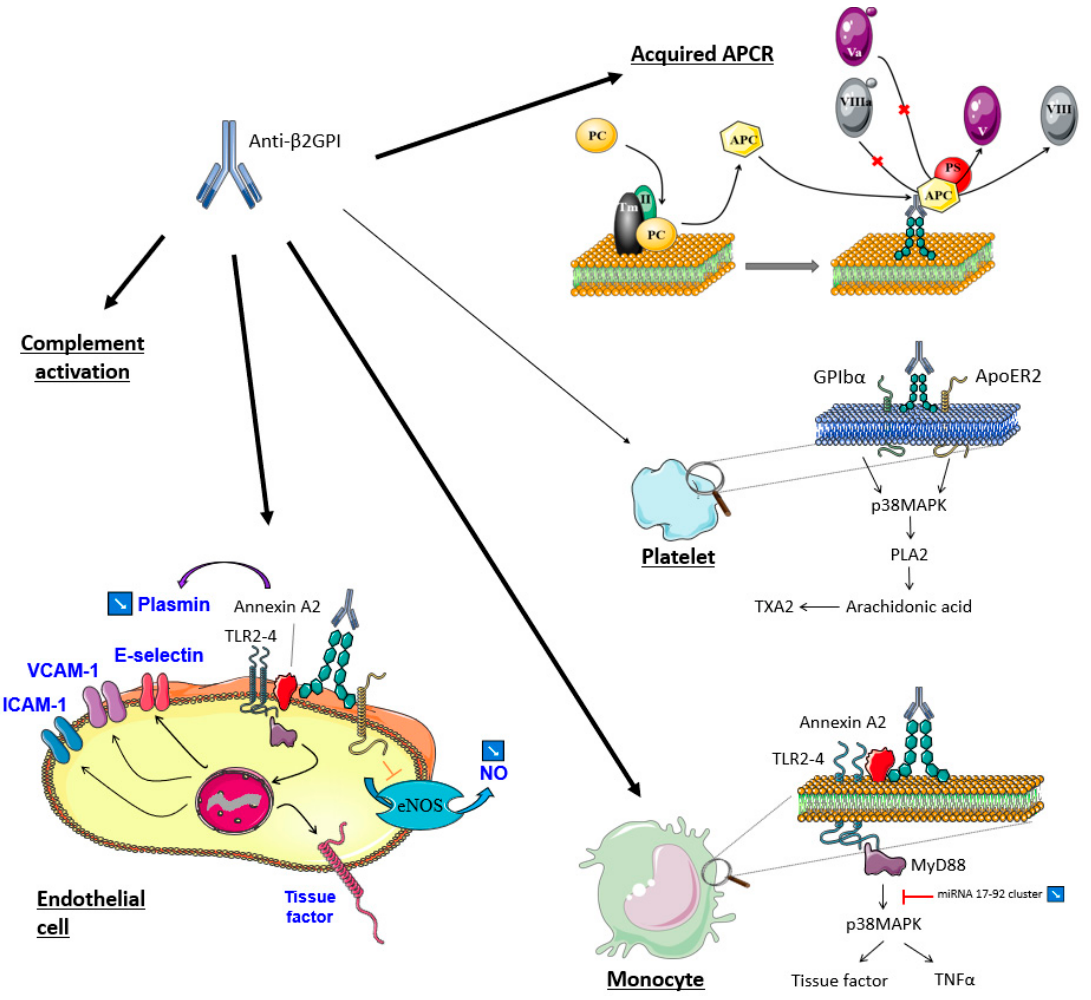
Figure 1. Mechanism of action of anti- β 2GPI antibodies in APS. Adapted from Masliah-Planchon J. et al., Rev. Med. Int., 2012 [14]. Anti- β 2GPI antibodies bind to negative phospholipids of endothelial cells, monocytes, and, to a lesser extent, platelets. By interacting with membrane receptors (GPIb α , ApoER2, TLR, and annexin A2), they trigger the activation of many intracellular kinases, thereby modulating the expression of procoagulant and anticoagulant molecules. In addition, this binding to membrane phospholipids induces acquired APCR by preventing the formation of coagulation